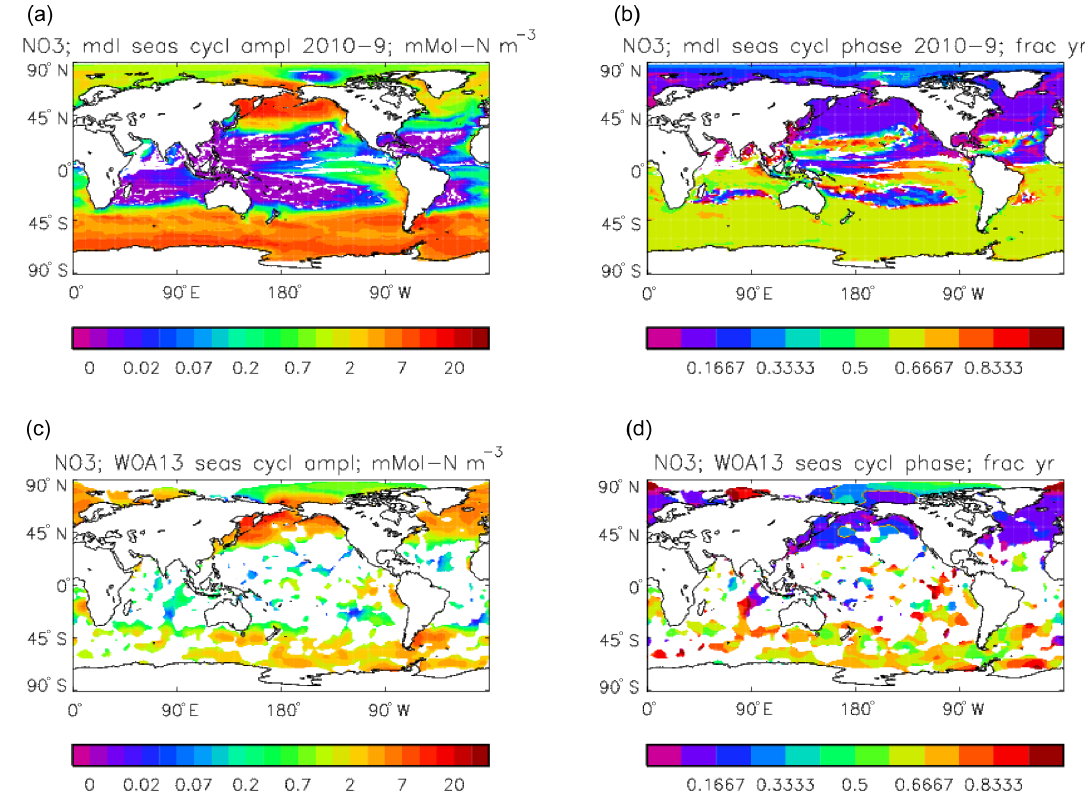
Figure 24. Surface dissolved nitrate seasonal cycle: (a, b) model cycle, averaged over model years 2010–2019; (c, d) the cycle from the monthly gridded fields from the 2013 World Ocean Atlas; (a, c) the amplitude of the cycle (mMolNm − 3 ); (b, d) the phase of the cycle (fraction of year). Only points for which the residual variance is less than half the original are